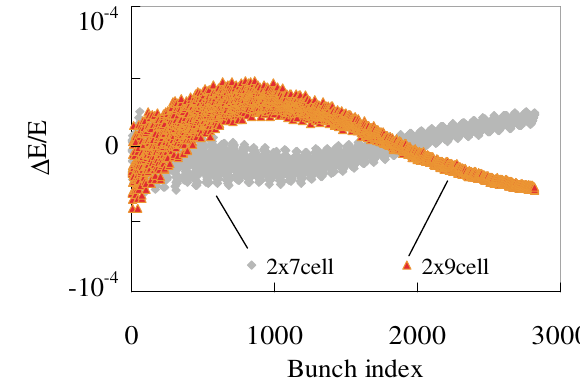
FIG. 2. (Color) Computed energy deviation for the TESLA beam: 2820 bunches, 3 : 2 nC = bunch , spacing 337